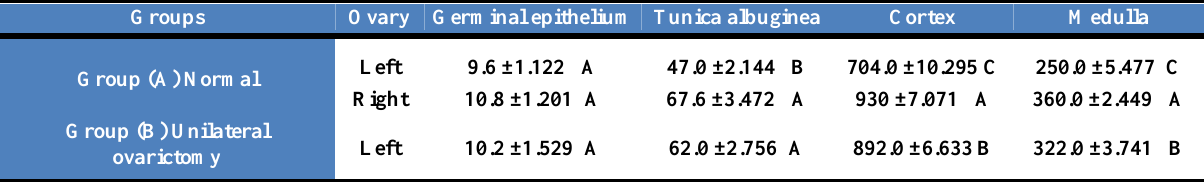
Table, 1: Histomorphometric value of the height and thickness of ovarian structures in the two groups of goats. (M± S.E.) in micrometers. Groups Ovary Germinal epithelium Tunica albuginea Cortex Medulla Left Group (A) Normal Group (B) Unilateral ovarictomy Different capital letters in same column denote significant differences